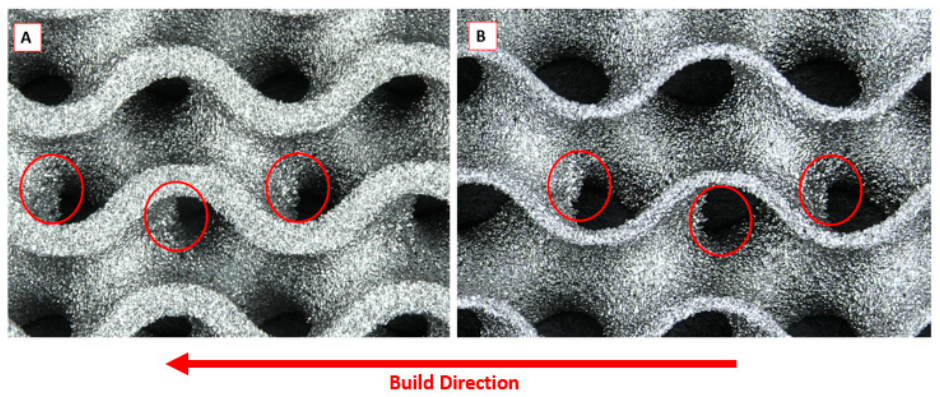
Figure 2. Stereozoom surface images of dross material (circled in red) observed in ( A ) 60% porous Ti6Al4V gyroid sample and ( B ) 80% porous Ti6Al4V gyroid sample produced by LPBF.